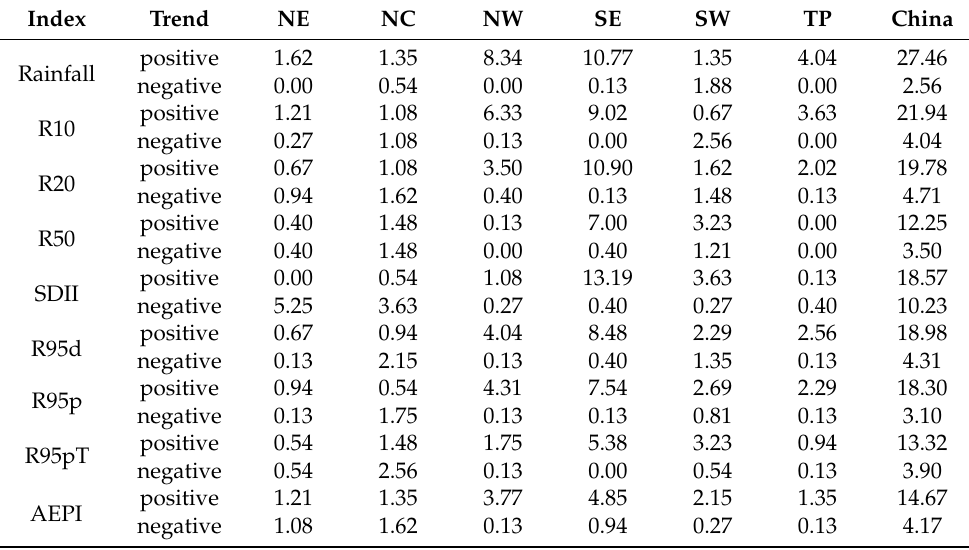
Table A3. The percentage of sites with significant trend (p < 0.1) in six regions of